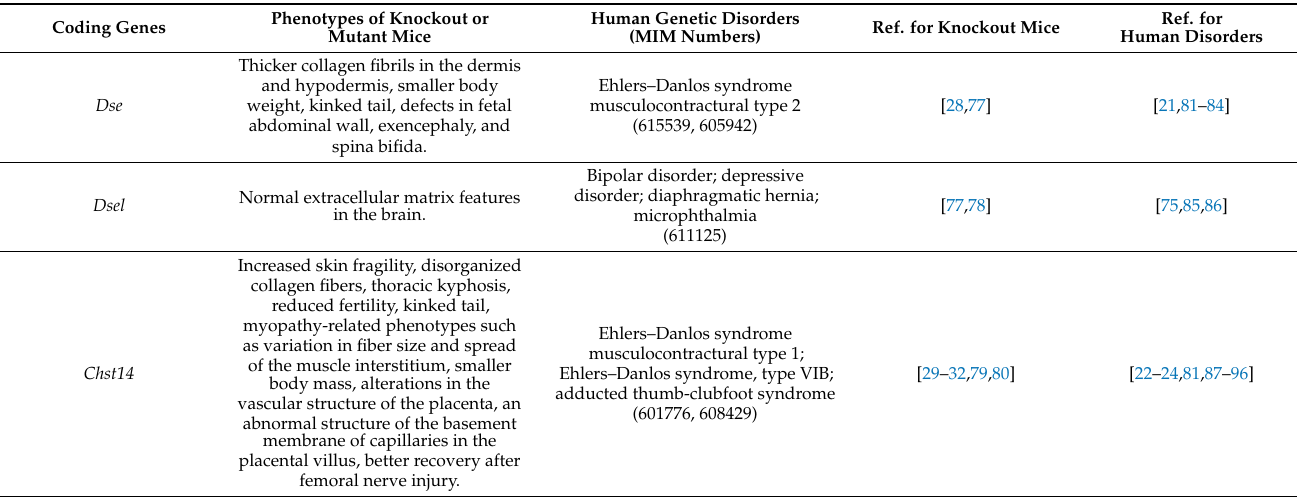
Table 2. DS-deficient mice and human